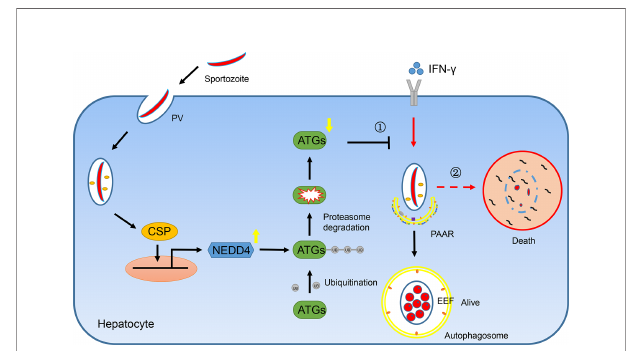
FIGURE 6 | A mechanistic pathway of CSP-mediated resistance to IFN- g - killing of EEFs in hepatocytes. ① After sporozoite invaded into hepatocytes, CSP on its surface would be translocated from PV into the cytoplasm of hepatocytes and is then introduced into nucleus dependent on its NLS domain. As a result, CSP activates the promoter of ligase3 NEDD4 and enhances its transcription. The upregulated NEDD4 promotes the ubiquitination of ATGs, leading to the degradation of ATGs. As ATGs are essential for IFN- g -mediated killing of EEFs, the CSP-mediated resistance to IFN- g , which is dependent on its ability to downregulate ATGs through enhancing NEDD4-mediated ubiquitination, facilitates the survival of EEFs. ② Otherwise, EEFs are destroyed by IFN- g